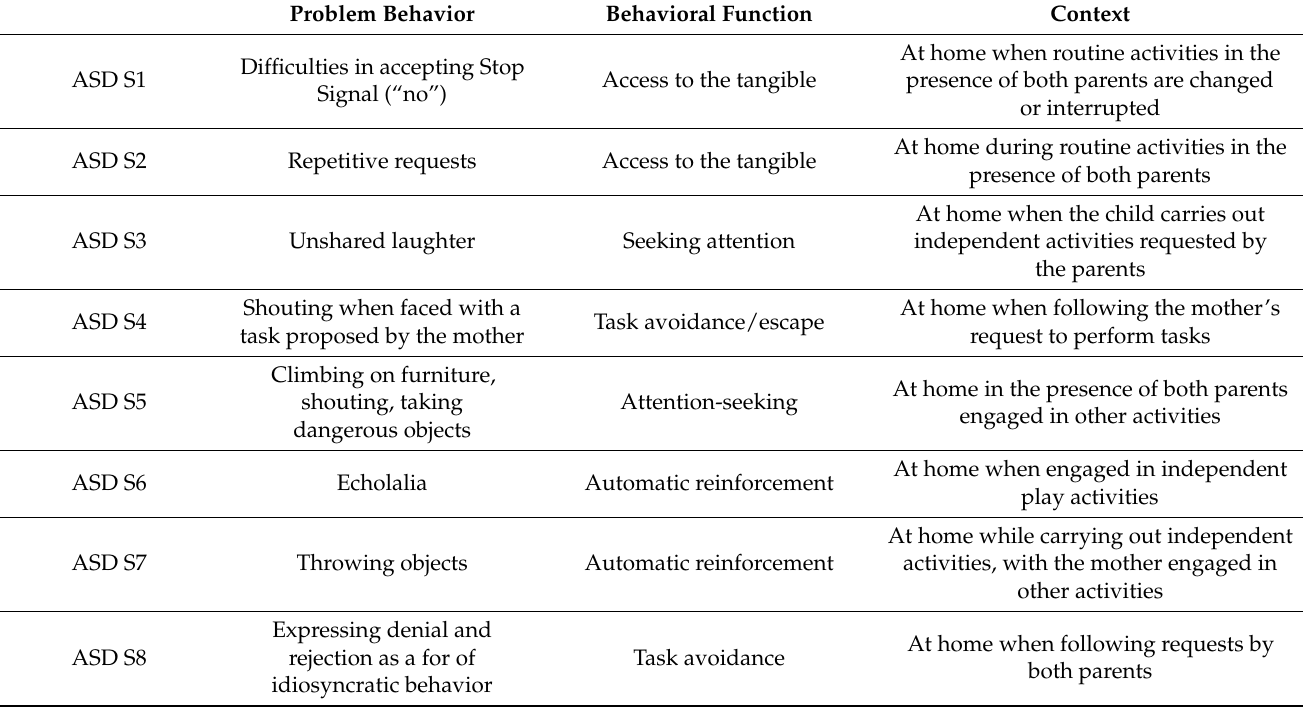
Table 4. Problem behaviors and relative function in the ASD children